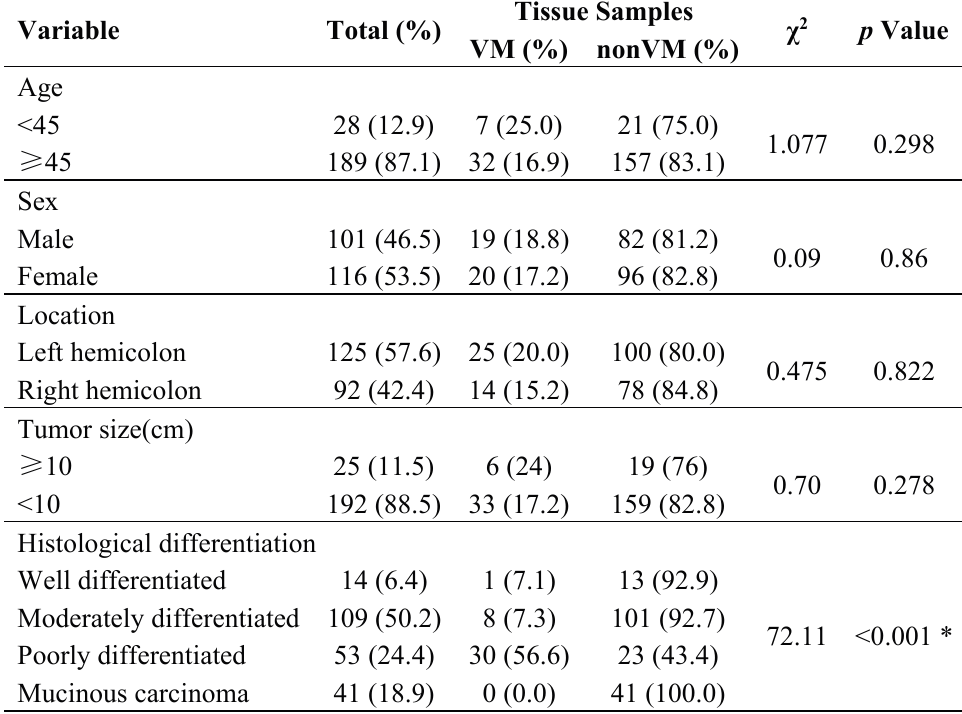
Figure 1. VM structure and endothelial-dependent vessels in colon cancer. ( A ) VM channel (red arrow) lined with tumor cells and containing red blood cells (H&E staining, ×400); ( B ) Endothelial-dependent vessel lined with flat endothelium cells (green arrow) (H&E staining, ×400); ( C ) VM channel formed by tumor cells was negative for CD34; the one lined with a base membrane-like structure was positive for PAS (red square frame); and the endothelial-dependent vessel was both positive for CD34 and PAS (black square frame) (CD34/PAS double staining, ×200). Table 1. Correlation between VM and clinicopathologic characteristics of colon cancer and expression of Wnt3a and β